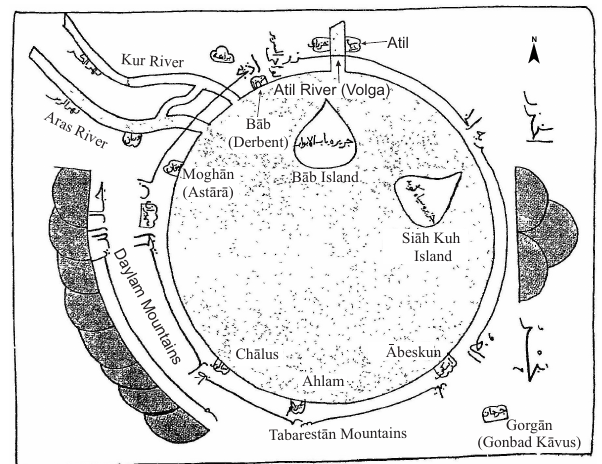
Fig. 7. The tenth century map of the Caspian Sea by Ibn Hawqal (1988). The map was rotated to show the north at the top and some of the names have been translated into English. ¯Abeskun, Gorg¯an, Ahlam and Ch¯alus were described as the most important ports of the south Caspian Sea by the tenth century